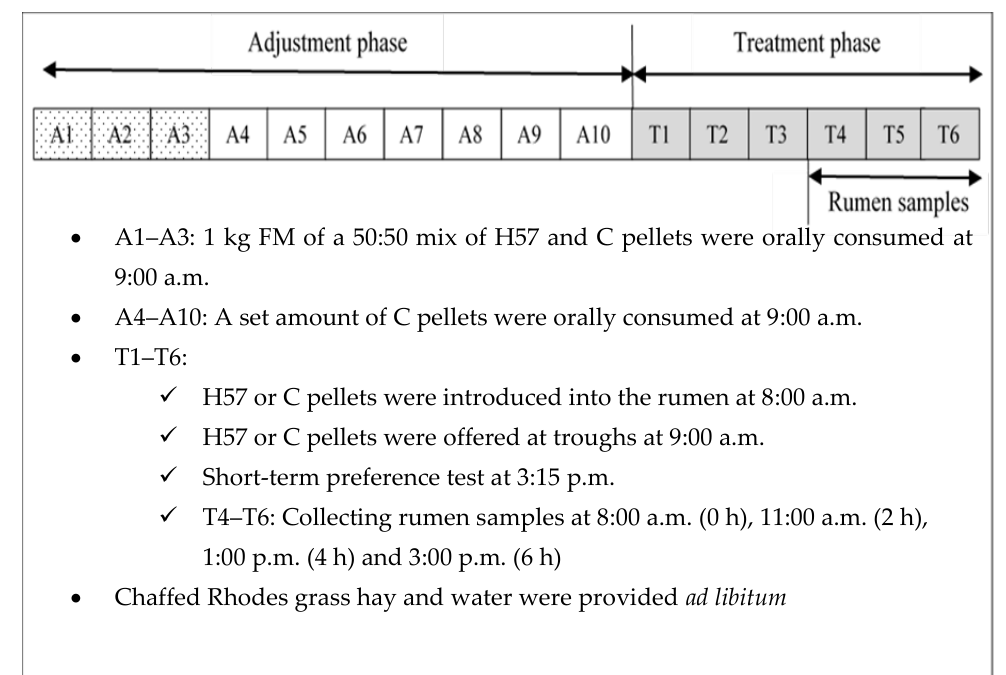
Figure 1. Over the course of the experiment, steers (n = 4) were subjected four times to an adjustment phase followed by a treatment phase so that they were tested on the four treatments according to either probiotic H57 (H57) or control (C) pellets that were ingested either orally (o) or introduced into the rumen (r) in the morning feeding.